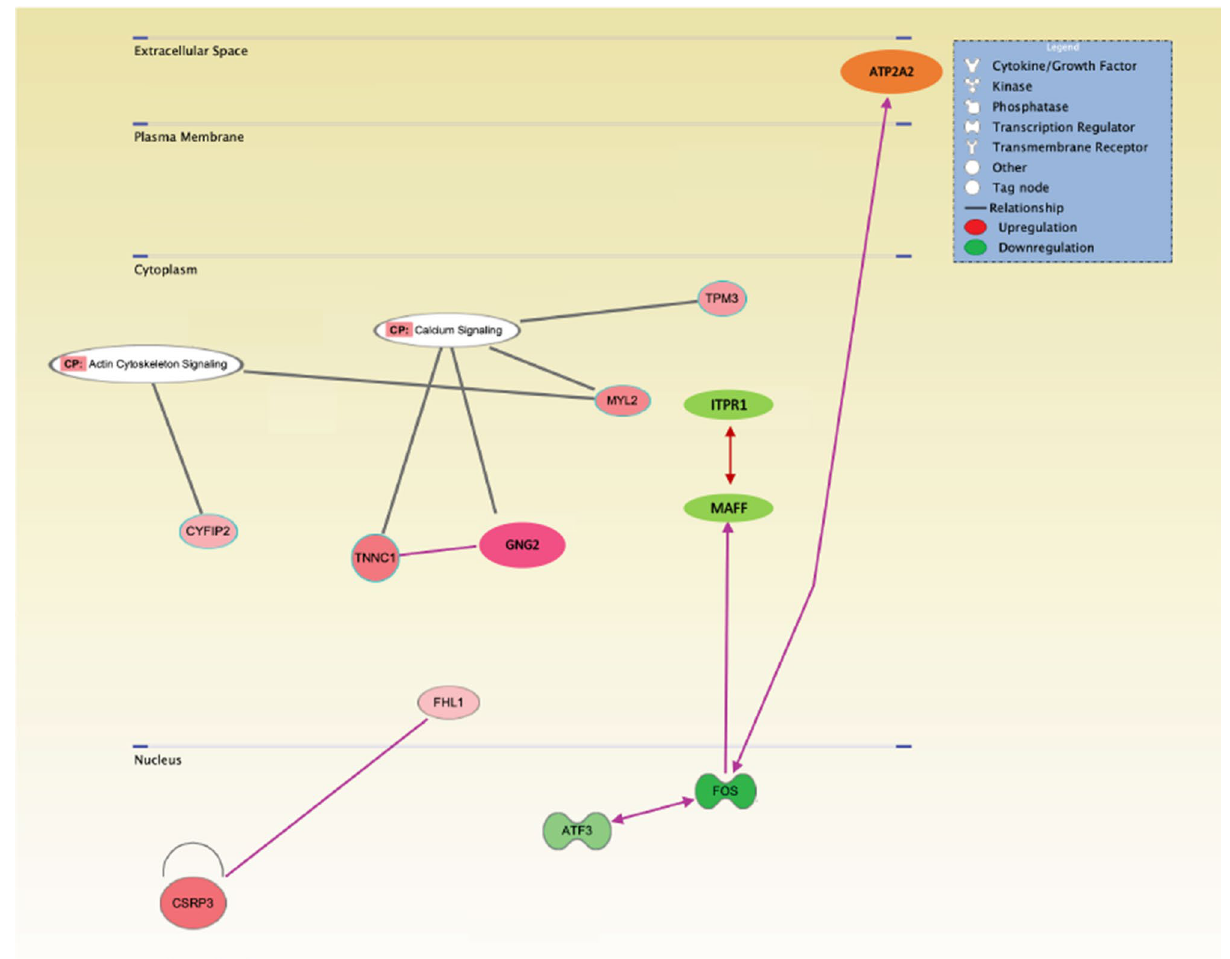
Figure 8. Functional annotation network. Ingenuity Pathway Analysis of alternations in energy metabolism, skeletal and muscular system development and function, and organismal injury and abnormalities in CKD mice relative to sham mice. Data were analyzed through the use of IPA (QIAGEN Inc., https ://www.qiage nbioi nform atics .com/produ cts/ingen uity-pathw ay-analy sis) 82 . The colored genes in the networks are differentially expressed between CKD mice relative to sham mice. Node color represents the expression status. Red: up-regulated in CKD mice relative to sham mice; green: down-regulated in CKD mice relative to sham mice. Increased expression of genes are ATP2A2, CSRP3, CYFIP2, FHL1, GNG2, MYL2, TNNC1 and TPM3, and decreased expression of genes are ATF3, FOS, ITPR1 and